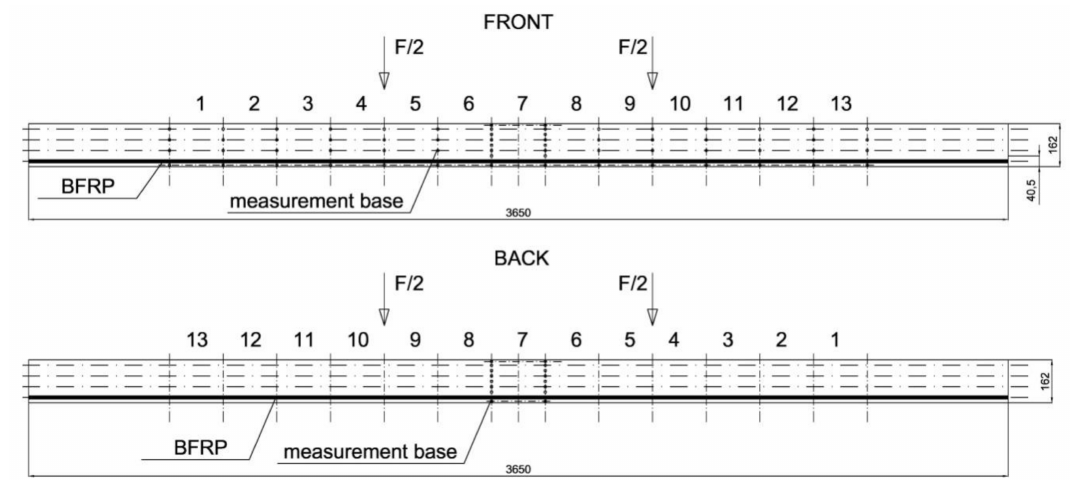
Figure 5. Layout of the measurement bases distributed at the front and at the back of W BFRP -A reinforced beams (dimensions in